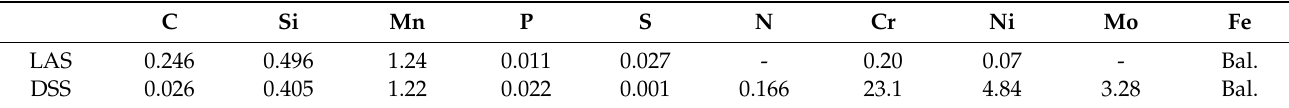
Table 1. The chemical composition of the constituent materials